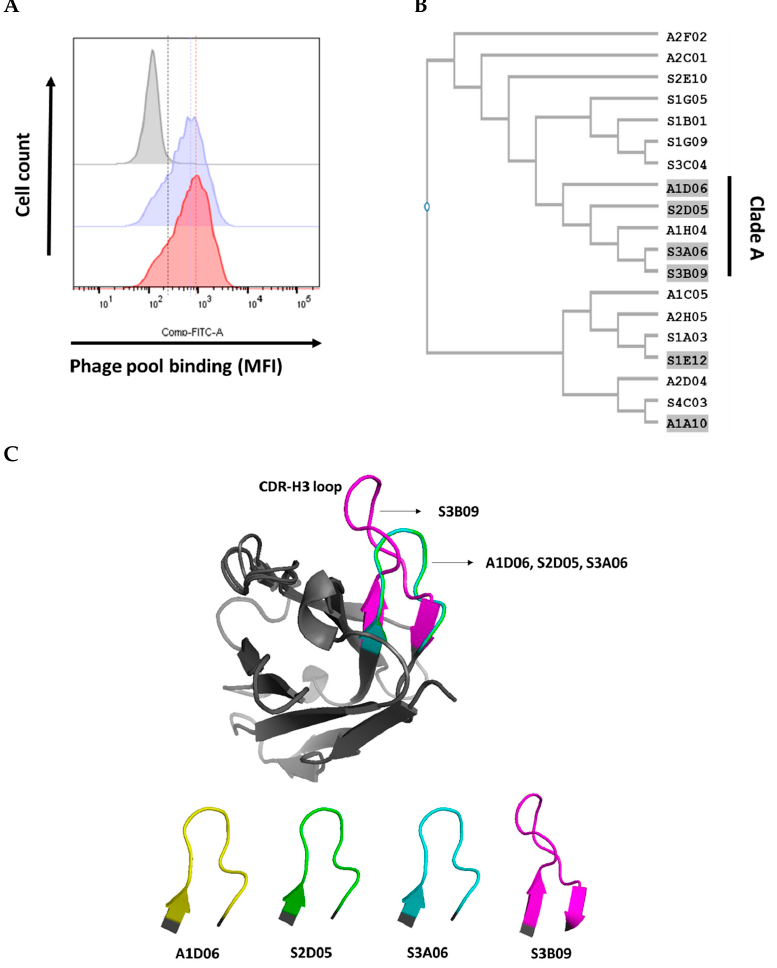
Figure 3. ( A ) Phage pool binding to FGFR3-overexpressing cells in a flow cytometer; comparison of cell surface binding between amplified phage pools obtained using conventional bio-panning (blue histogram) only or with the introduction of cell panning (red histogram). Comparison of CDR-H3 sequence similarity of isolated antibodies through cell panning introduction. ( B ) Phylogenetic tree of similar sequences built on the basis of CDR-H3 (Kabat numbering) using CLUSTAL W multiple sequence alignment programs. Each phylogenetic tree was analyzed for 13 clones selected through conventional bio-panning only and 6 clones selected through introduction of cell panning. The A1D06, S2D05, S3A06, and S3B09 clones were grouped into “Clade A.” ( C ) Comparison of CDR-H3 loop structure alignment using POSA analysis (interactive multiple protein structure alignment). The CDR-H3 of the A1D06 (yellow), S2D05 (green), S3A06 (cyan), and S3B09 (magenta) clones of Clade A were aligned based on the VH region in the Fv modeling annotation. CDR-H3 loop structure and length are different for each clone (gray, framework).